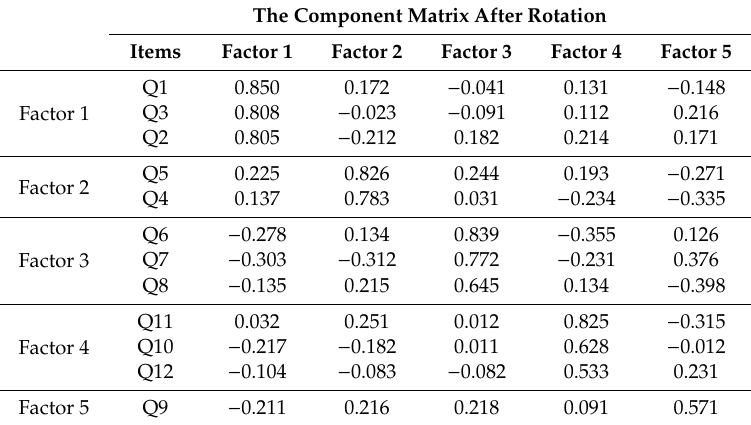
Table 5. Rotational matrix of safety consciousness.